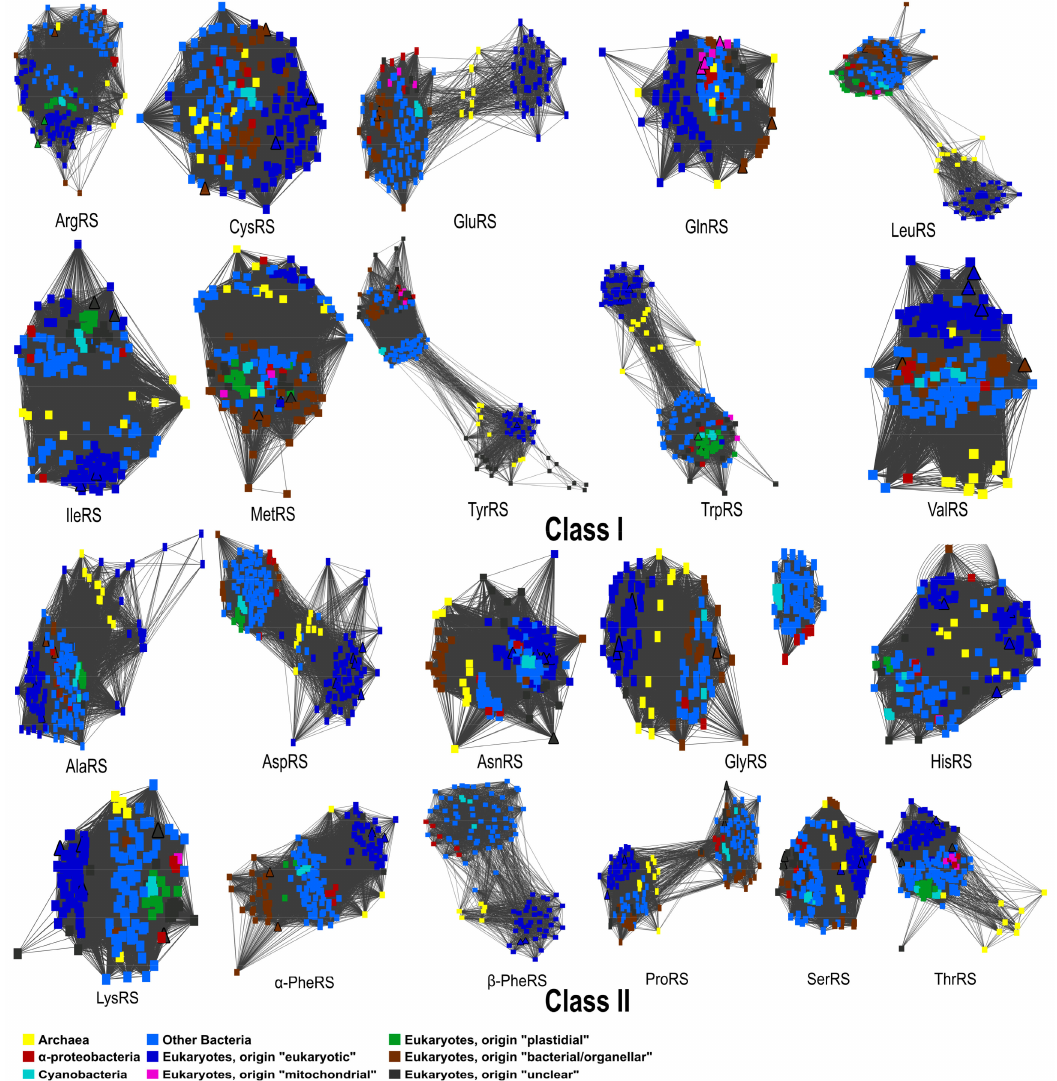
Figure 2. A similarity network for each sequence dataset of the 20 di ff erent Aminoacyl-tRNA synthetases shows the sequence similarity and reflects the phylogenetic tree topology of each Aminoacyl-tRNA